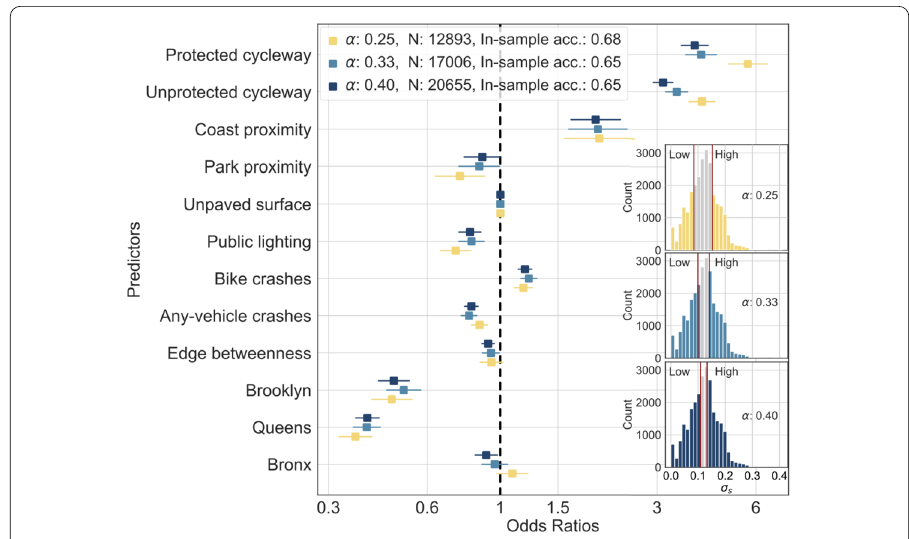
Figure 5 Odds Ratios of multivariate logistic regressions, for several levels of the threshold α a ) the chart presents estimated ORs for a multivariate logistic regression where the target variable is the binarized σ s and the predictors are listed in Table 2. The squared dots are the point estimates. The straight lines are the estimated 95% confidence interval for the corresponding OR. The model was estimated on three different sample selections, with the threshold α corresponding to 0.25 (yellow), 0.33 (light-blue) and 0.40 (dark blue). The ORs are computed exponentiating the corresponding estimated coefficients. For each estimated model, the legend reports the value of the threshold α , the number of observations and the in-sample accuracy. b ) The histograms show the mapping between the σ s and the binarized σ s for the three values of the threshold α : 0.2 5 (yellow), 0.33 (light blue) and 0.40 (dark